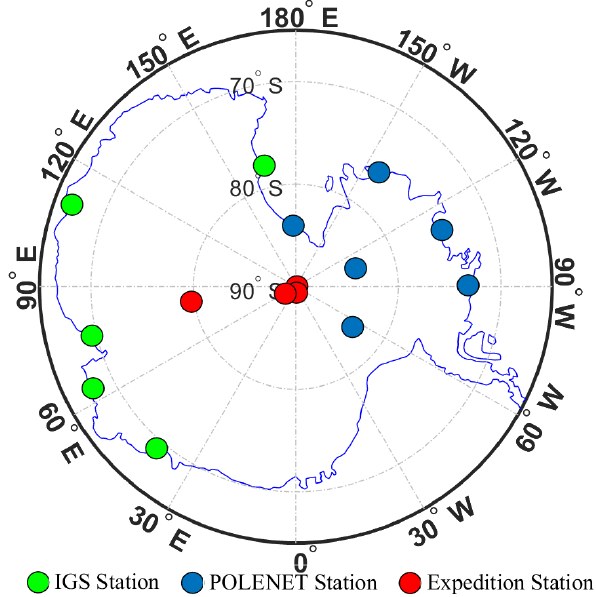
Figure 1. Distribution diagram of Global Navigation Satellite System stations in Antarctica.